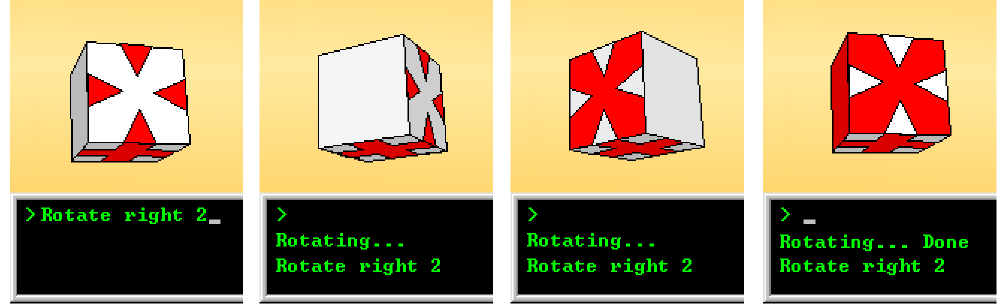
Figure 7. An example of rotating the cube when the type of agency is verbal. Figure 8. An example of rotating the cube when the type of agency is verbal.